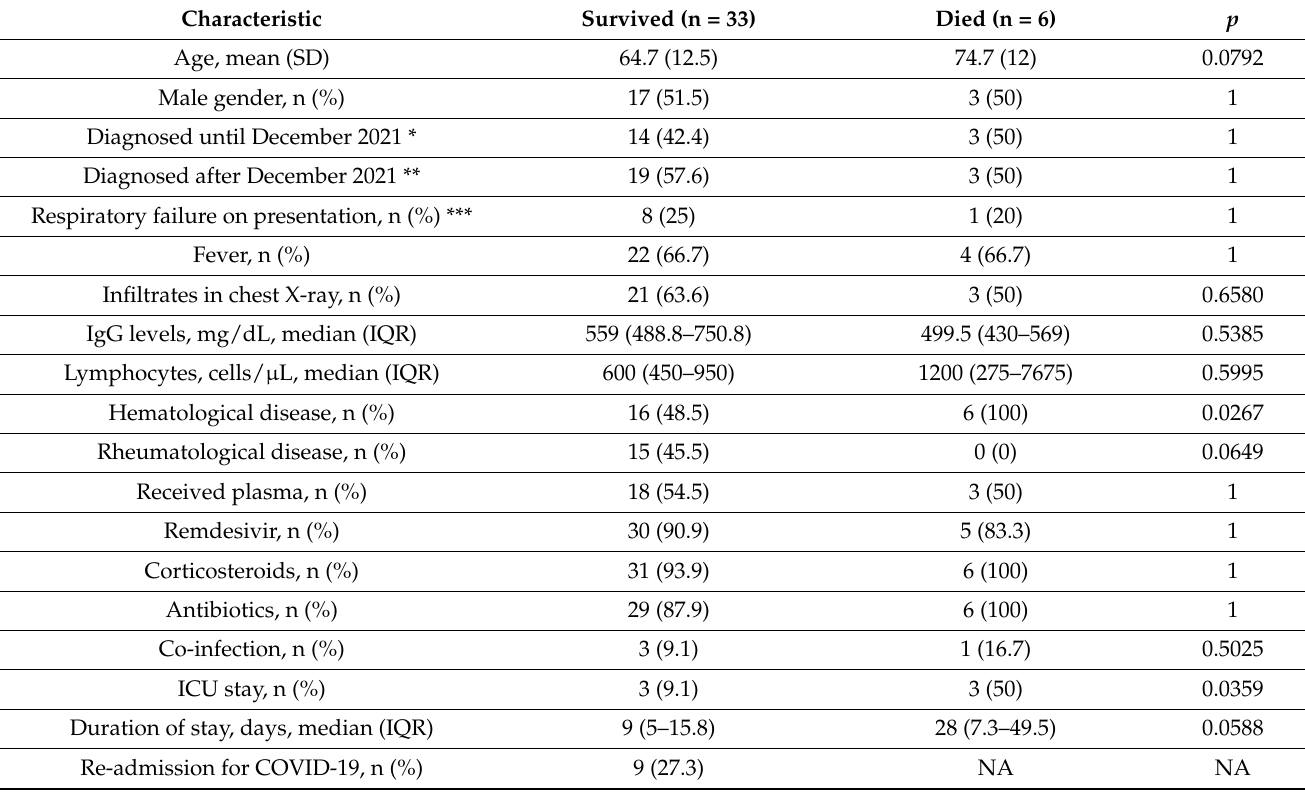
Table 2. Patients’ characteristics in regard to